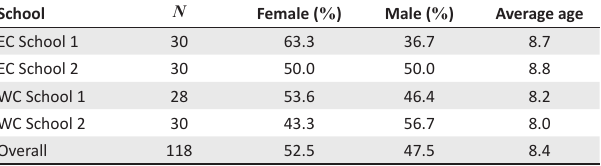
TABLE 3: Active word knowledge test: Participants per school, gender distribution and average age (January 2016). School